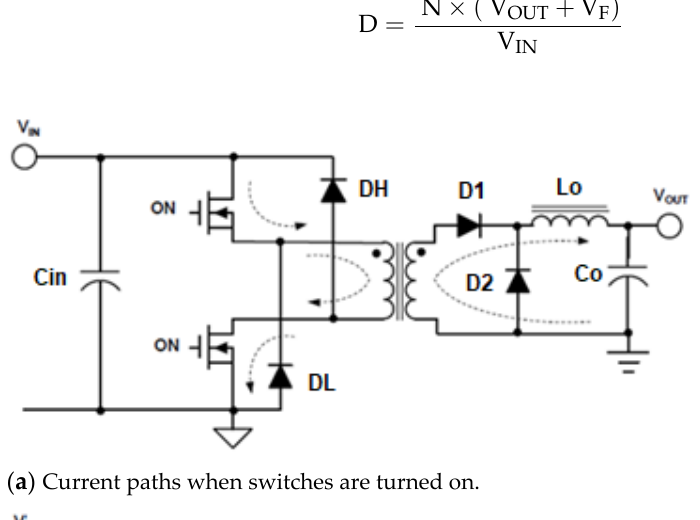
Figure 10. Dual-Switch Forward converter topology.